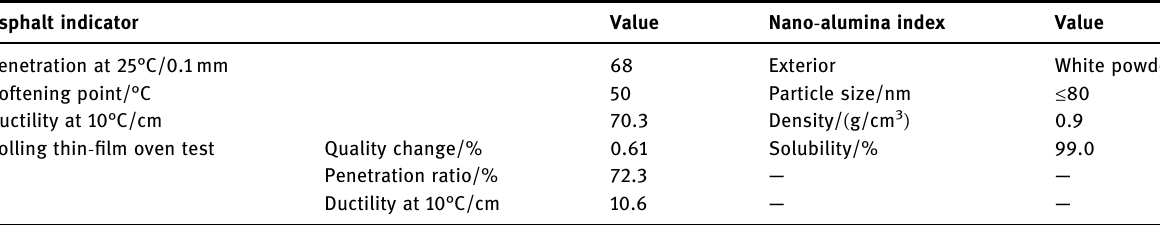
Table 2: Properties of 70# matrix asphalt and nano - alumina Asphalt indicator